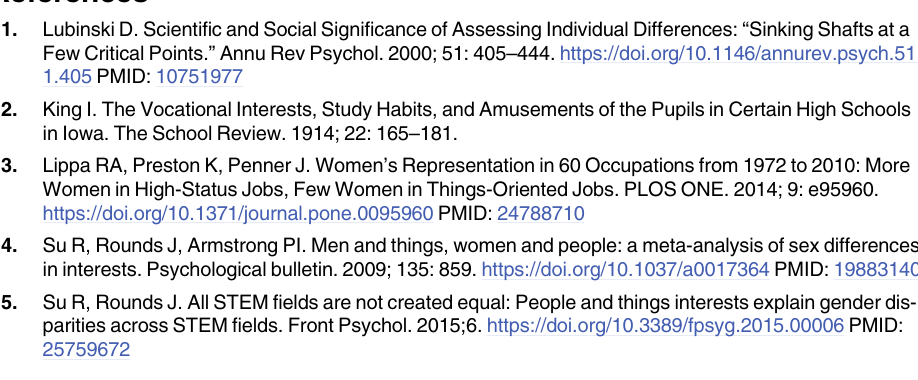
S1 Table. Detailed country data. For each country, we list the number of boys and girls with career aspiration data, the percentages of boys and girls with a things, people, or STEM ori- ented career aspiration (as well as the ratios), the overall PISA score (average of mathematics, science, and reading), the Global Gender Gap Index (GGGI), and the national wealth